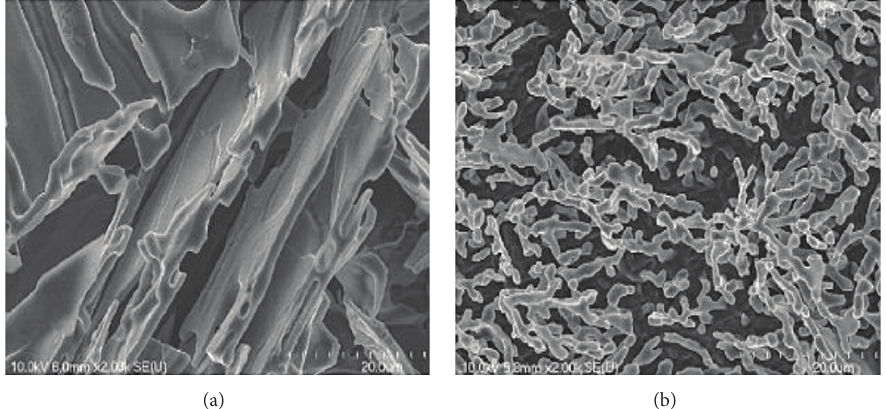
Figure 14: Secondary electron images of etched binary Al-7%Si alloy samples obtained from the graphite mold: (a) nonmodified and (b) modified with 54 ppm Sr [1].